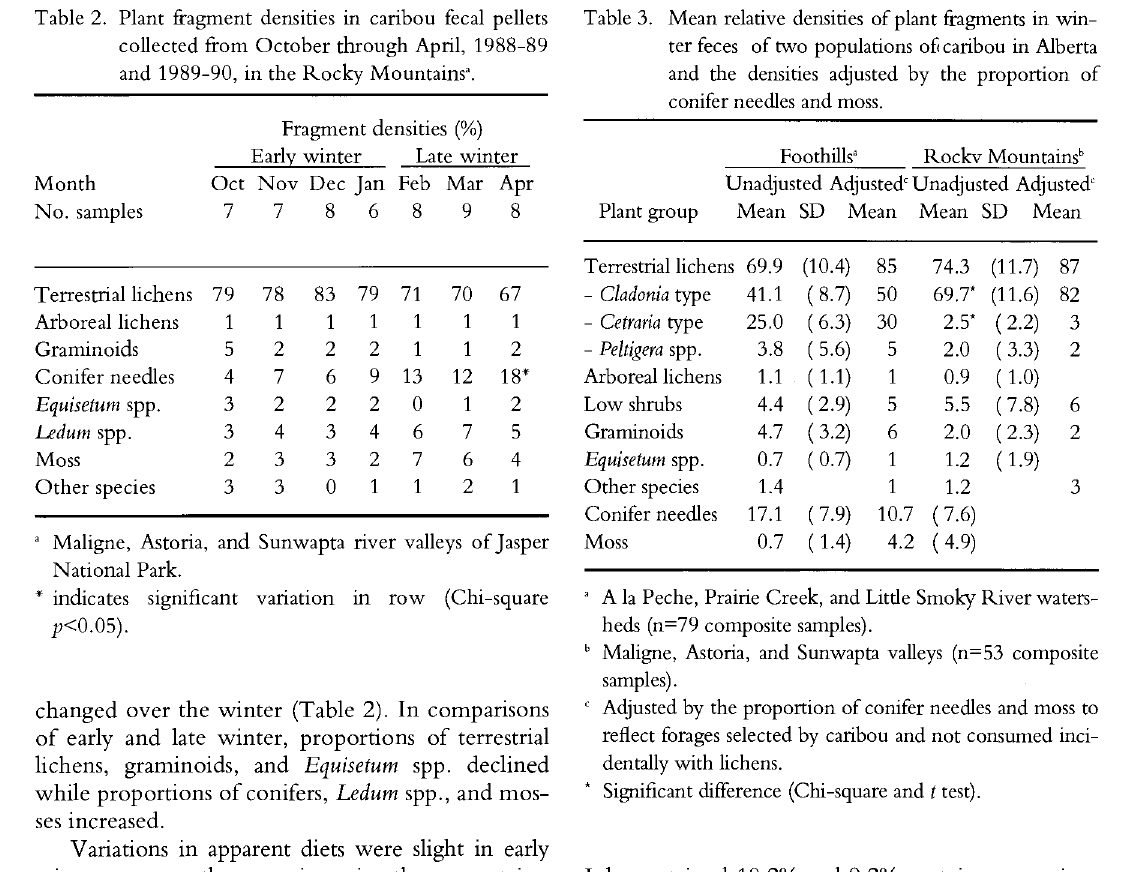
ter feces of two populations of caribou in Alberta and the densities adjusted by the proportion of conifer needles and